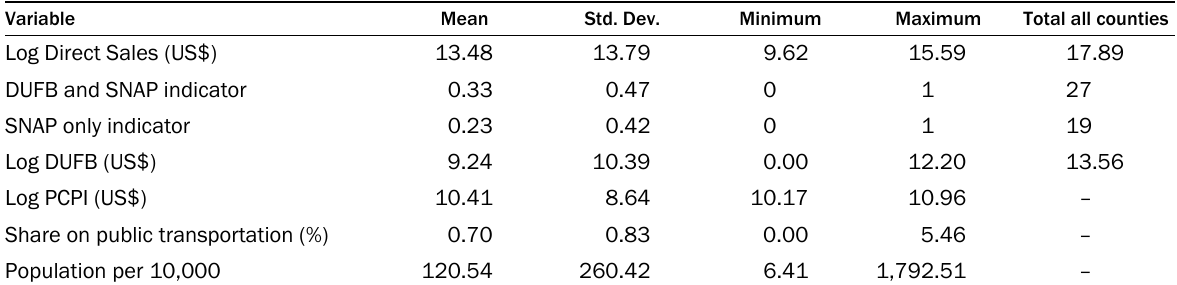
Table 2. Summary Statistics of County-Level Data in Regression Model, 2012